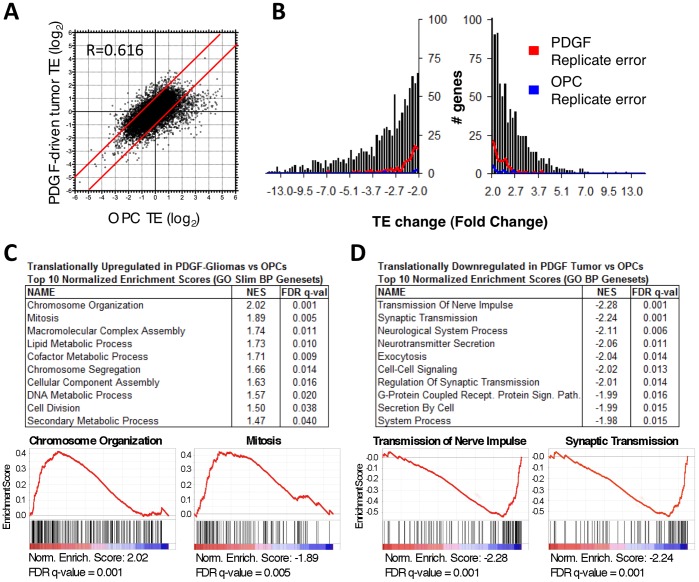
Translation efficiency was altered in glioma compared to normal brain OPCs.(A) Changes in ribosome-bound mRNA correlated somewhat with changes in total cellular RNA between tumor and normal brain OPCs (N = 4). (B) Alterations in TE between tumor and normal brain were reproducible, exceeding average replicate error. (C) Genesets associated with cell division and biosynthetic pathways predominated amongst GOSlim Biological Process genesets most enriched for transcripts translationally upregulated in Olig2+tumor cells compared to normal brain OPCs. Enrichment plots for chromosome organization and mitosis genesets shown. (D) Genesets associated with synaptic signaling predominated amongst GO Biological Process genesets most enriched for transcripts translationally downregulated in Olig2+tumor cells compared to normal brain OPCs. Enrichment plots for transmission of nerve impulse and synaptic transmission shown. NES = Normalized Enrichment Score. R = Pearson correlation coefficient.